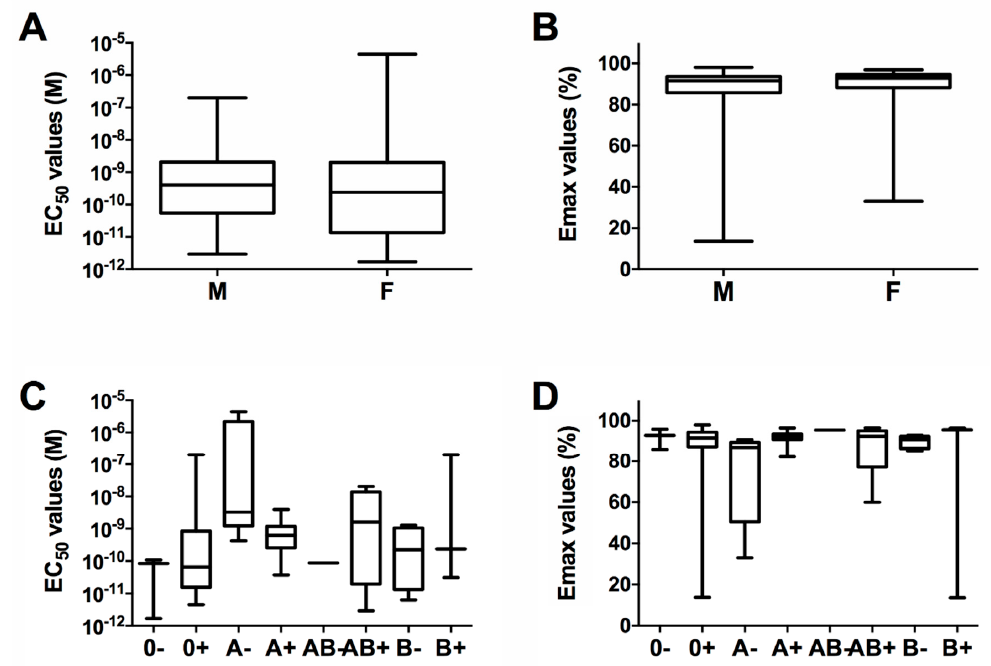
Figure 3. Distribution of EC 50 ( A , C ) and Emax ( B , D ) values measured by the MTT assay in monocytes from the 60 healthy volunteers exposed to PLTX from 4 h, within genders (male = 41; female = 19) (A,B) or blood groups (0 − = 3; 0 + = 22; A − = 5; A + = 12; AB − = 1; AB + = 10; B − = 4; B + = 3) (panels C,D). For each volunteer, EC 50 and Emax values were the means of three experiments performed in triplicate.